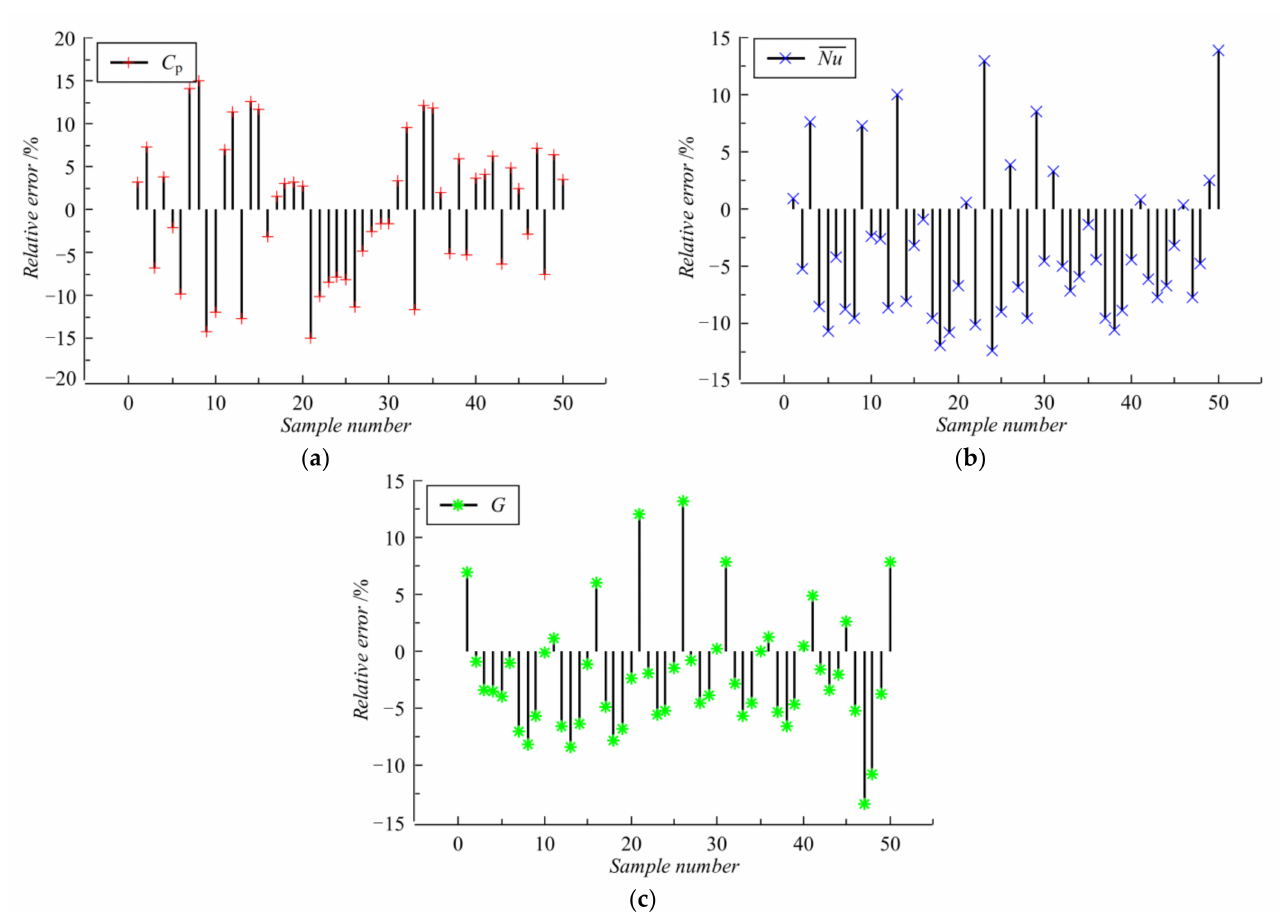
Figure 15. Fitting errors: ( a ) C p ; ( b ) Nu ; ( c ) G